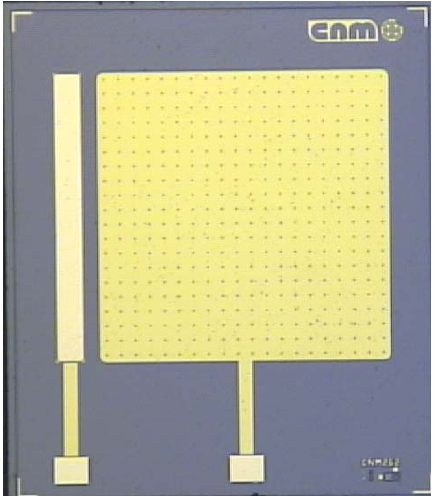
Figure 4. Image of an UMEA with 5 µm disk diameter and 100 µm inter-electrode